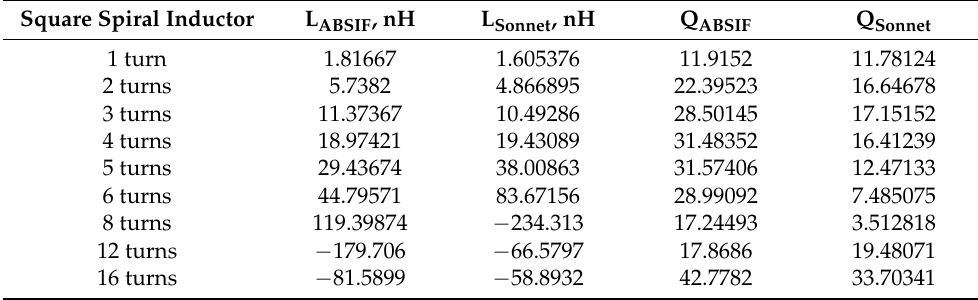
Table 5. Comparison of the results obtained by ABSIF and Sonnet at 4 GHz.